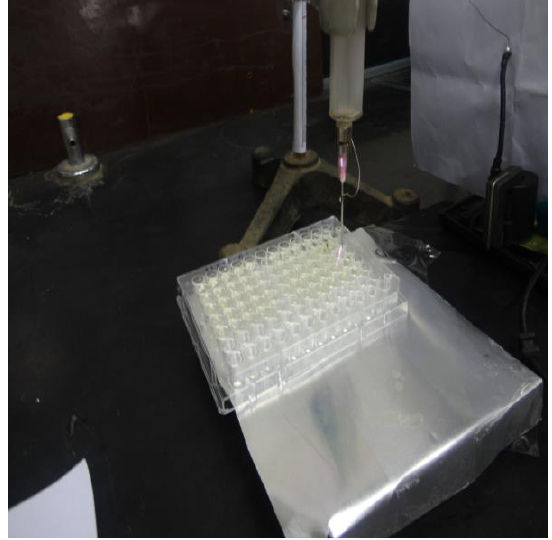
Fig.2: Experimental setup for bacterial treatment